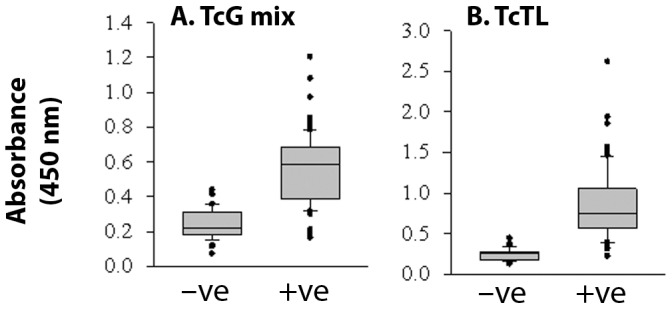
TcGmix-based ELISA was effective in diagnosing exposure to T. cruzi infection among inhabitants of Chiapas Mexico.Sera samples obtained from volunteers living in the endemic areas of Chiapas Mexico were characterized as seropositive (+ve) and seronegative (−ve) by whole-parasite antigen based serology tests in the 1st phase. Shown are the antibody response captured by an ELISA using mixture (TcGmix) of recombinant TcG1, TcG2 and TcG4 proteins (A) or T. cruzi trypomastigote lysate (TcTL) (B) as a source of antigen.